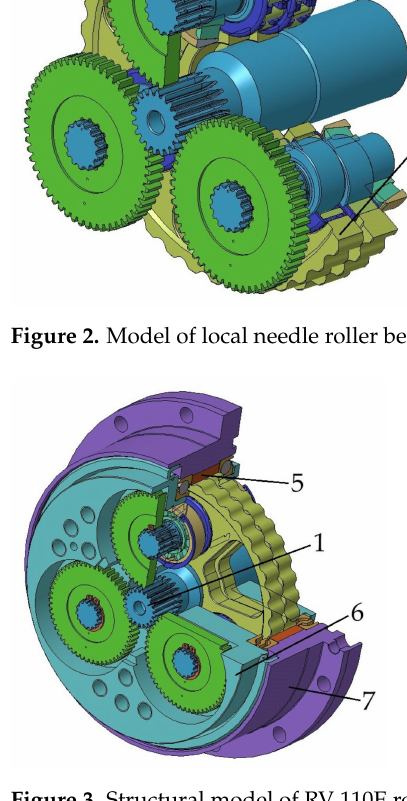
Figure 3. Structural model of RV 110E